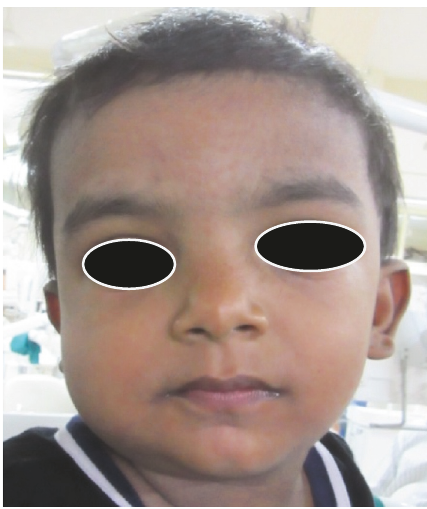
Figure 1: Swelling in relation to lower lateral side of